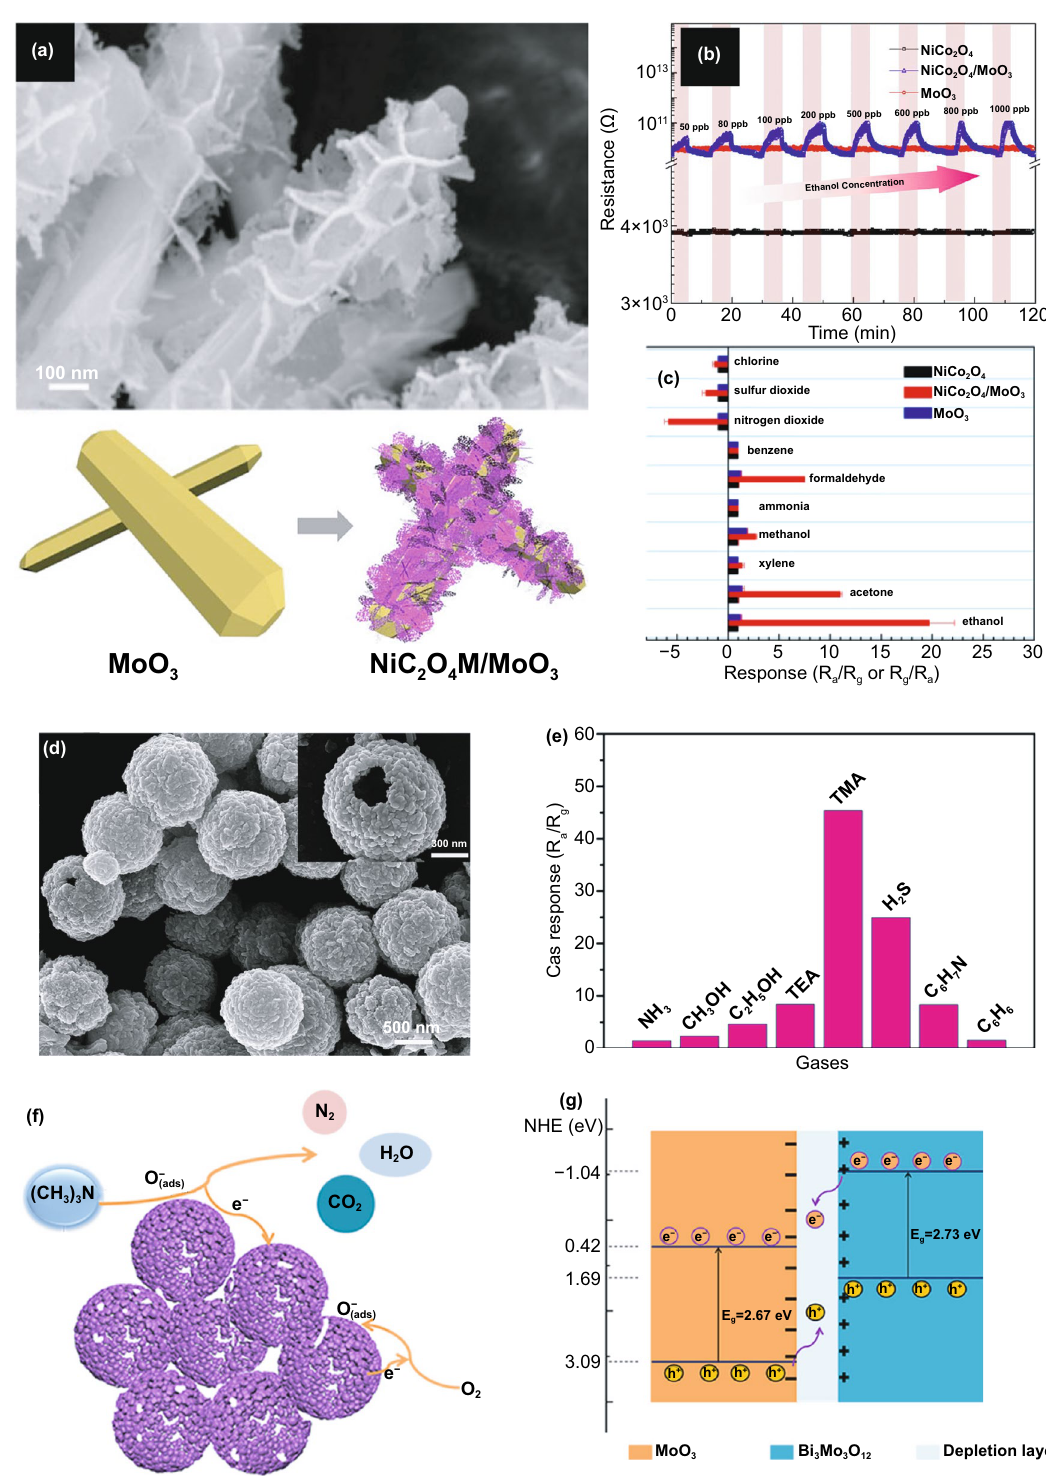
Fig. 8 a p–n heterostructure was constructed by NiCo 2 O 4 / α -MoO 3 nanorods with ( b, c ) sensing response and selectivity to 1 ppm of ethanol at 350 °C. Reprinted with permission from Ref. [80]. Copyright 2019 Elsevier 2020. d Hollow heterostructures consisted of MoO 3 /Bi 2 Mo 3 O 12 exhibited selective sensing toward TMA e . The proposed sensing mechanism ( f, g ) showed electron–hole transfer processes between MoO 3 and Bi 2 Mo 3 O 12 upon the contact. Reproduced from Ref. [140] with permission. Copyright 2019 American Chemical